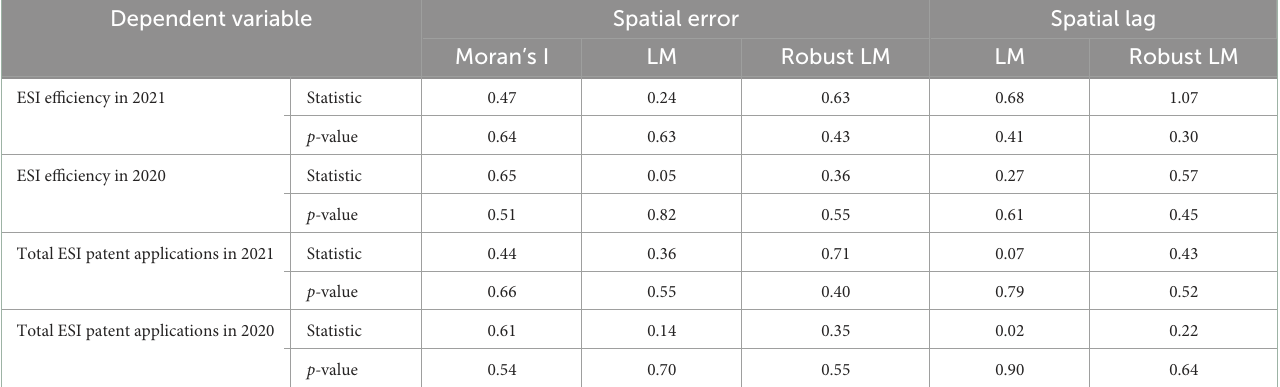
TABLE 7 Spatial Tobit regression results.